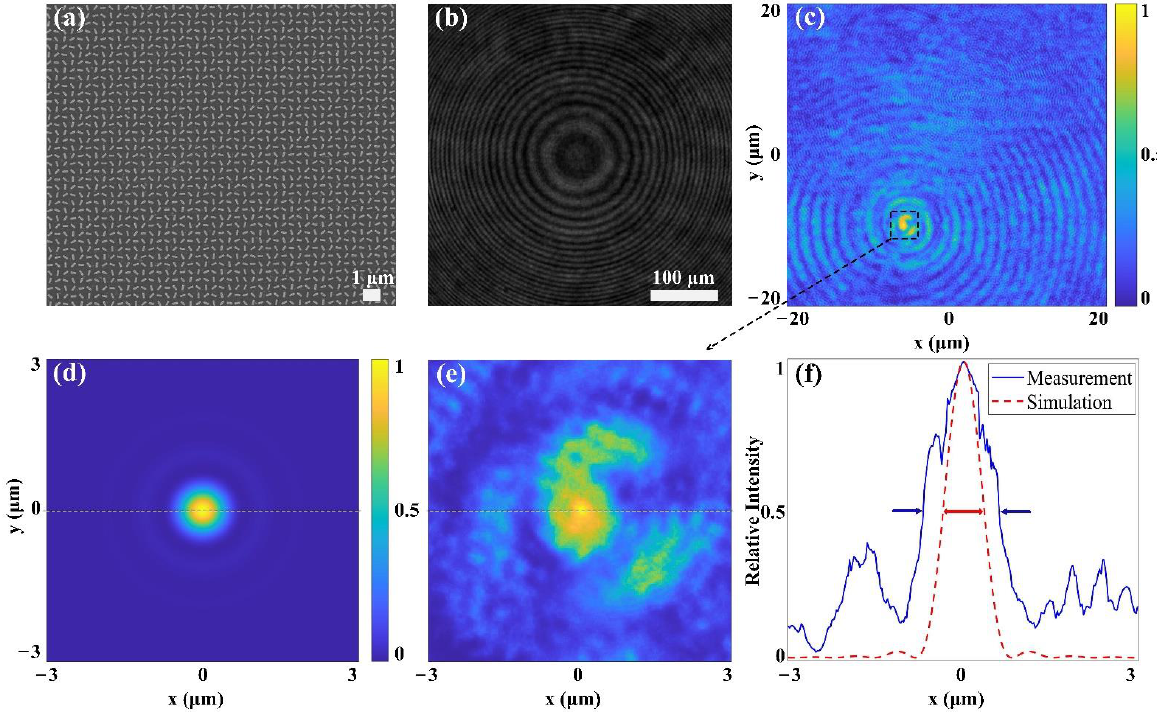
Figure 5. The characterizations of the fabricated singlet metalens. ( a ) A scanning electron micrograph (SEM) image of the local part from the fabricated metalens. ( b ) Optical image of the central part from the fabricated metalens under 532 nm microscopic illuminating light. ( c ) Measured focal spot intensity profile at 532 nm wavelength by a commercial object (100 × OLYMPUS, NA = 0.90). ( d ) Simulated focal spot intensity profile at 532 nm wavelength by FDTD method. ( e ) Magnified image of the measured focal spot intensity profile from ( c ). ( f ) Central focal spot intensity profiles along horizontal axis from ( d ) and ( e ), respectively.